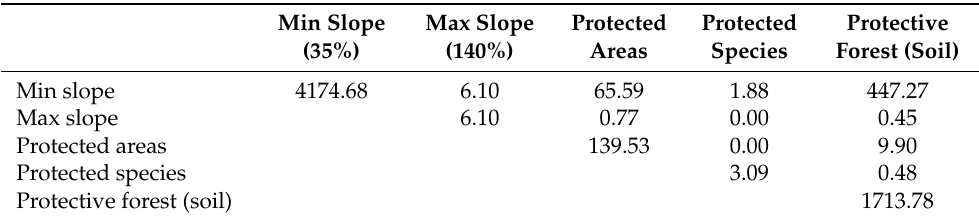
Table 4. Overlapping forest areas (1000 ha) of forest not available for wood supply in Spain, applying different restrictions.